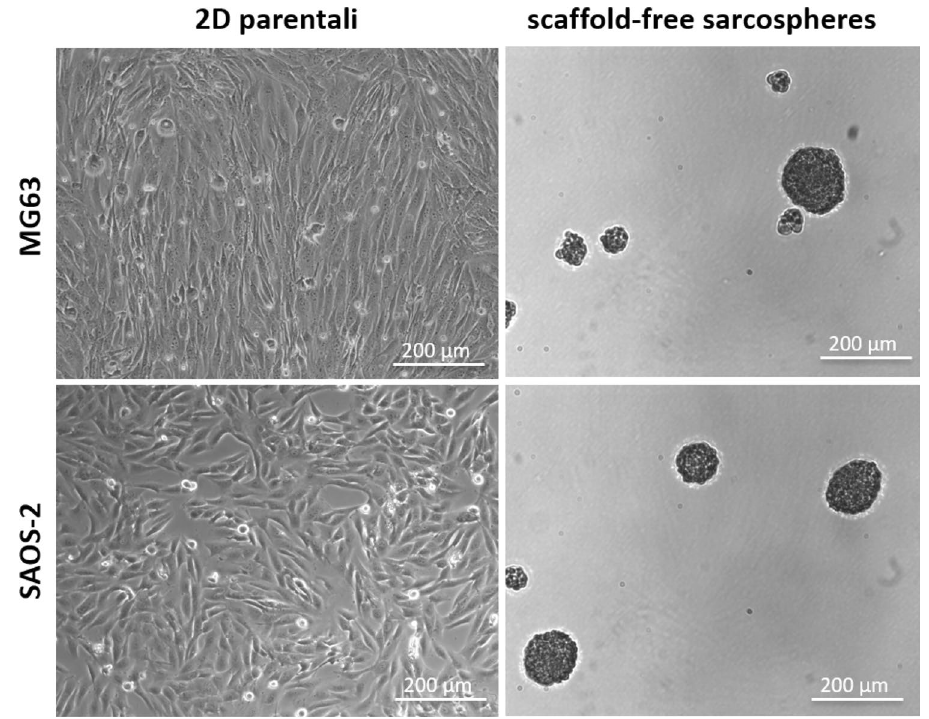
Figure 1. Qualitative morphological characterization of sarcospheres. Parental cells grown adherent to 2D standard support showing their typical morphologies. Stable floating